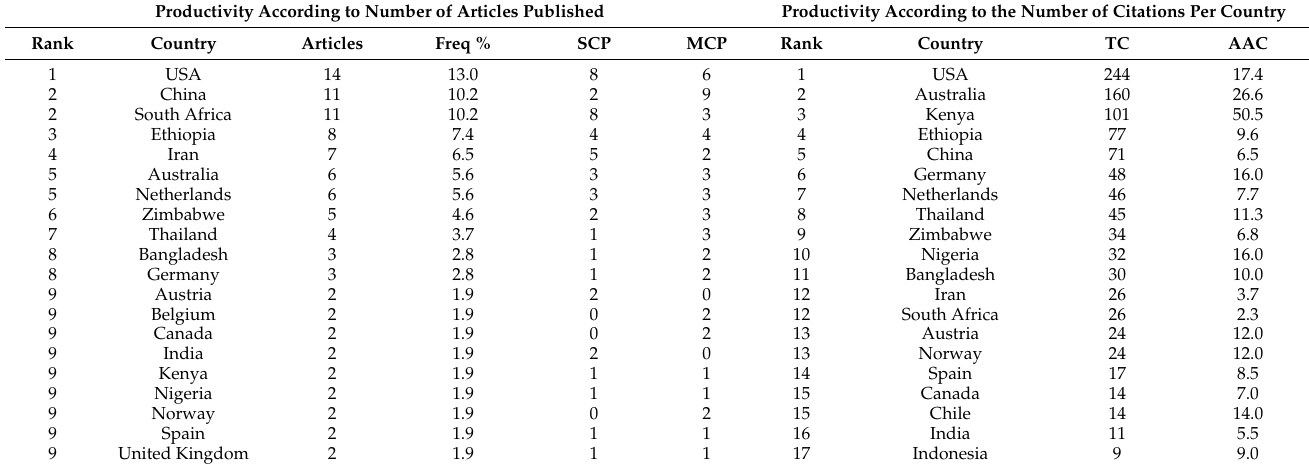
Table 4. Top 20 most productive nations by corresponding authors in the PASSFDR documents indexed in Scopus (2011–2020).